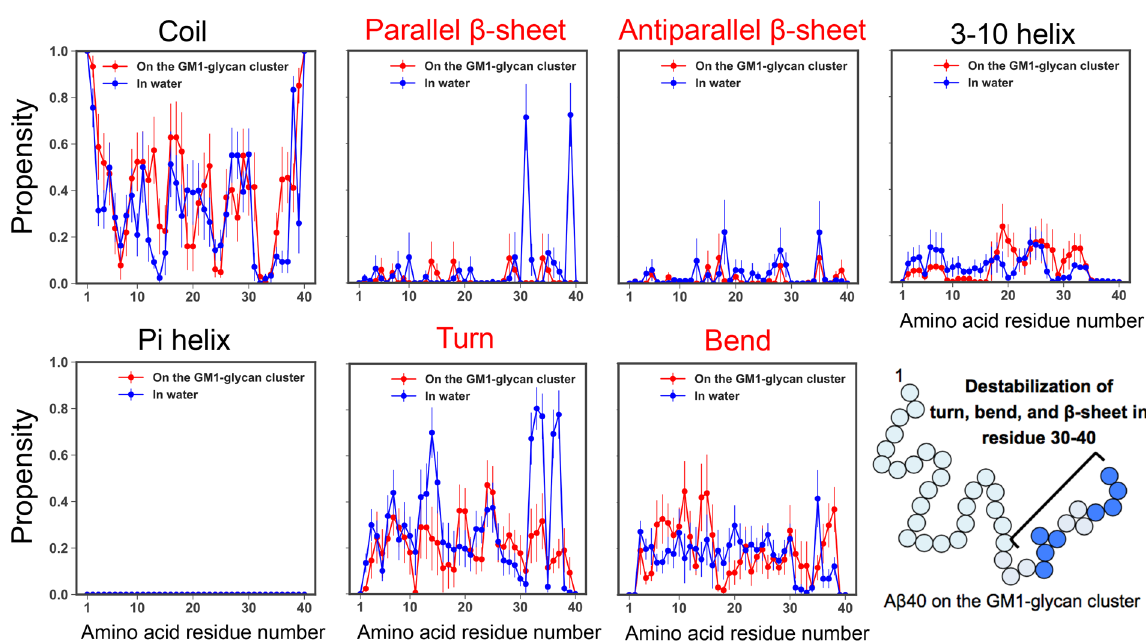
Figure 7. Propensities of each secondary structure except the helix structure in each amino acid residue assigned by the DSSP algorithm 44 . The average values and standard errors were estimated by the Jackknife method 45